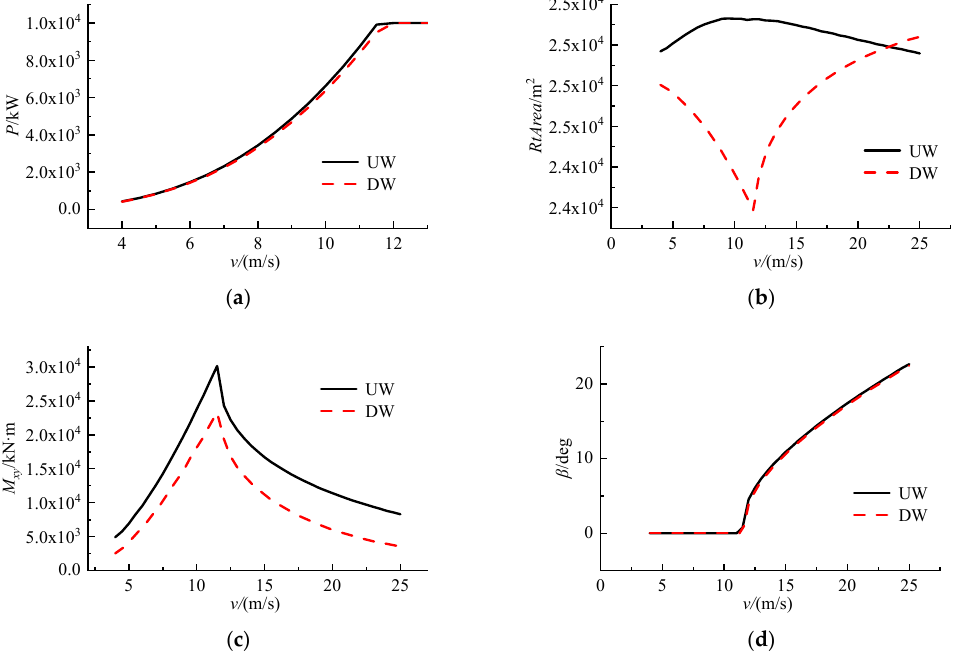
Figure 2. ( a ) Output power curves. ( b ) Rotor swept area curves. ( c ) Loads of blade root curves. ( d ) Pitch angle curves.